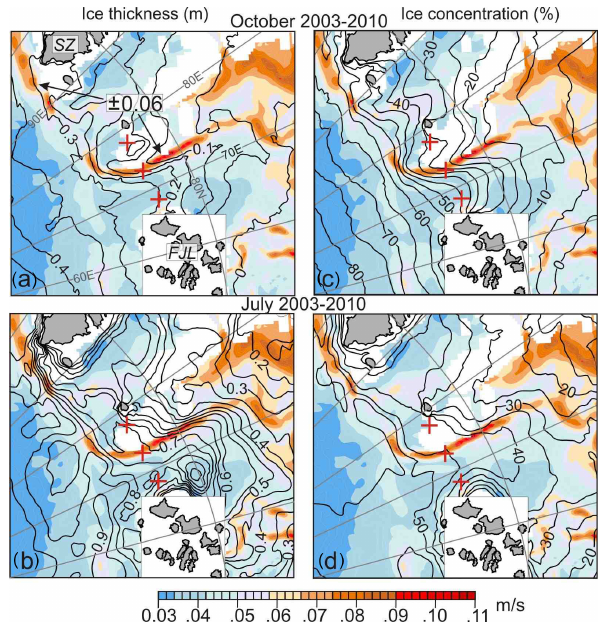
Figure 8. The 7-year mean (2003–2010) simulated velocity vertical difference ( 1V ) in the 0–75m layer (ms − 1 ) in the northern Kara Sea with overlaid simulated mean (a, b) sea-ice thickness (m) and (c, d) concentration (%) for (a, c) October and (b, d) July. Crosses depict locations along 81 ◦ N where the measured June–November time series of sea-ice concentration are compiled in Fig. 12. (a) The arrowed number shows ± 1 standard deviation for the 1V maxi- mum over the ST eastern flank and Kara Sea continental margin obtained using monthly mean velocity